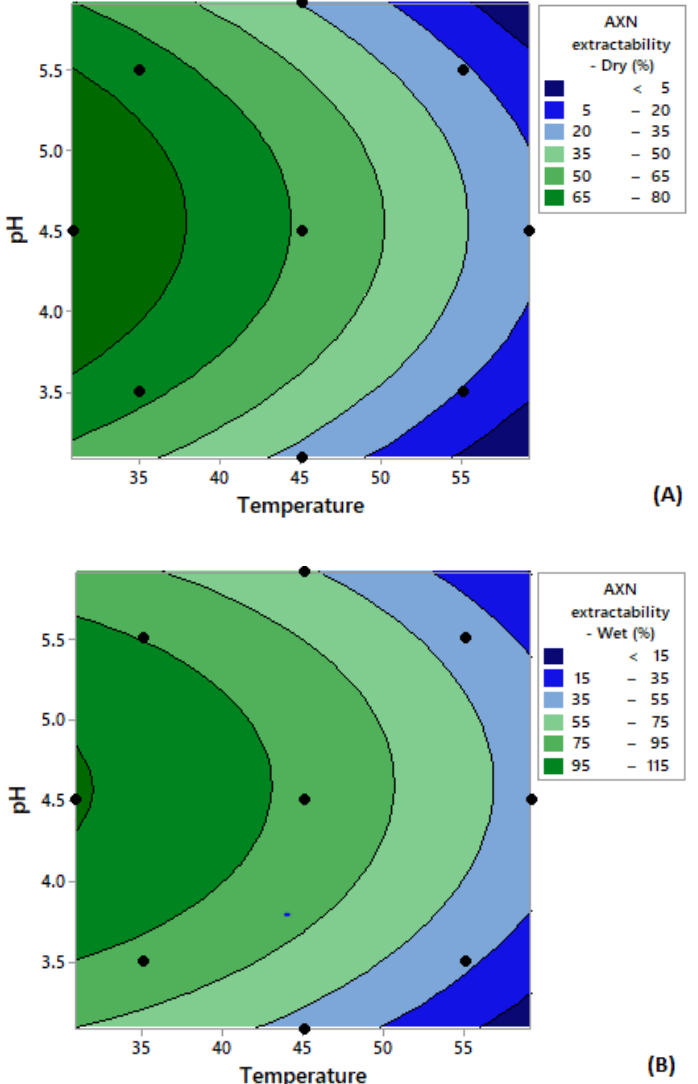
Figure 5. Contour plots depicting the effect of temperature and pH on astaxanthin extractability from X. dendrorhous cells following Glucanex on ( A ) dry cells and ( B ) wet cells. * The black dots on the contour plot represent the experimental points. Abbreviation: AXN—astaxanthin.